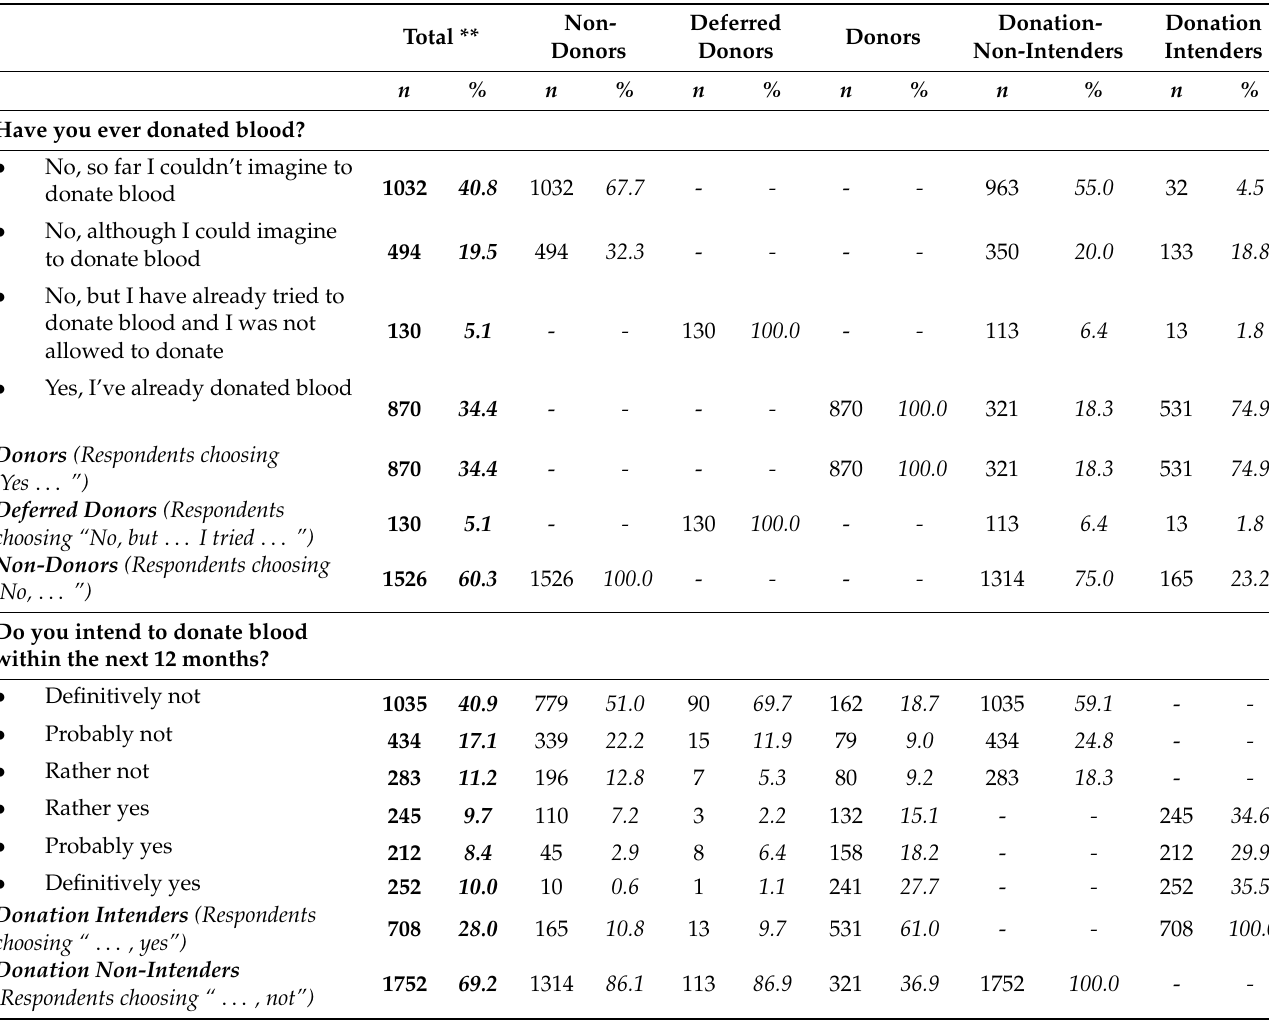
Table A2. Self-reported retrospective (lifetime) and prospective (12 months) blood donation behaviour—results for total sample ( n = 2531, weighted) *.